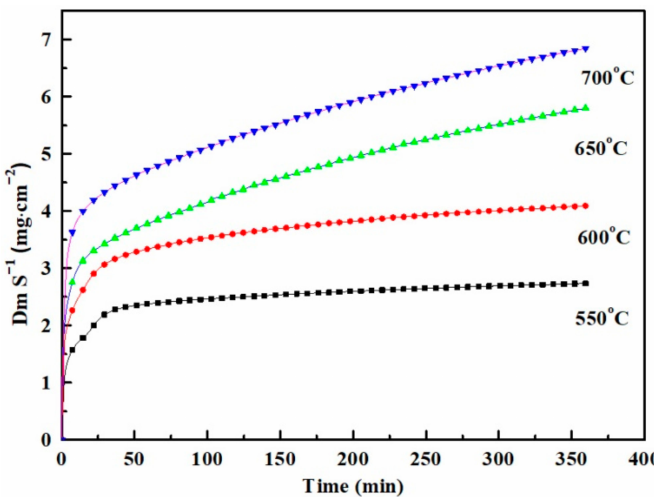
Figure 5. Mass gain graph of the Mg coated samples, after isothermal oxidation at 550, 600, 650, 700 ◦ C.